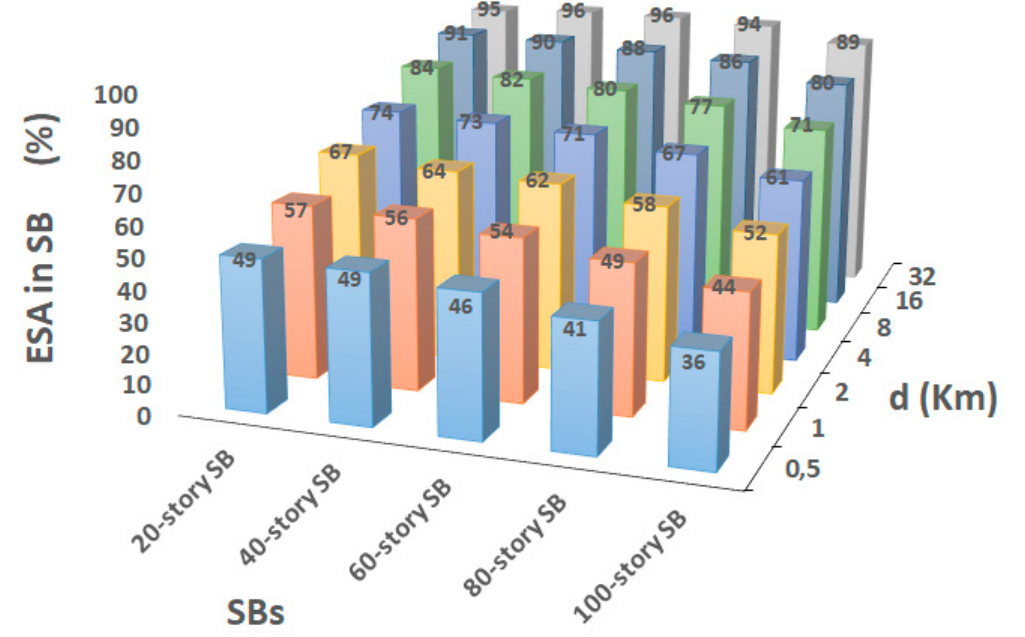
Figure 13. ESA behavior for di ff erent H SB and d .